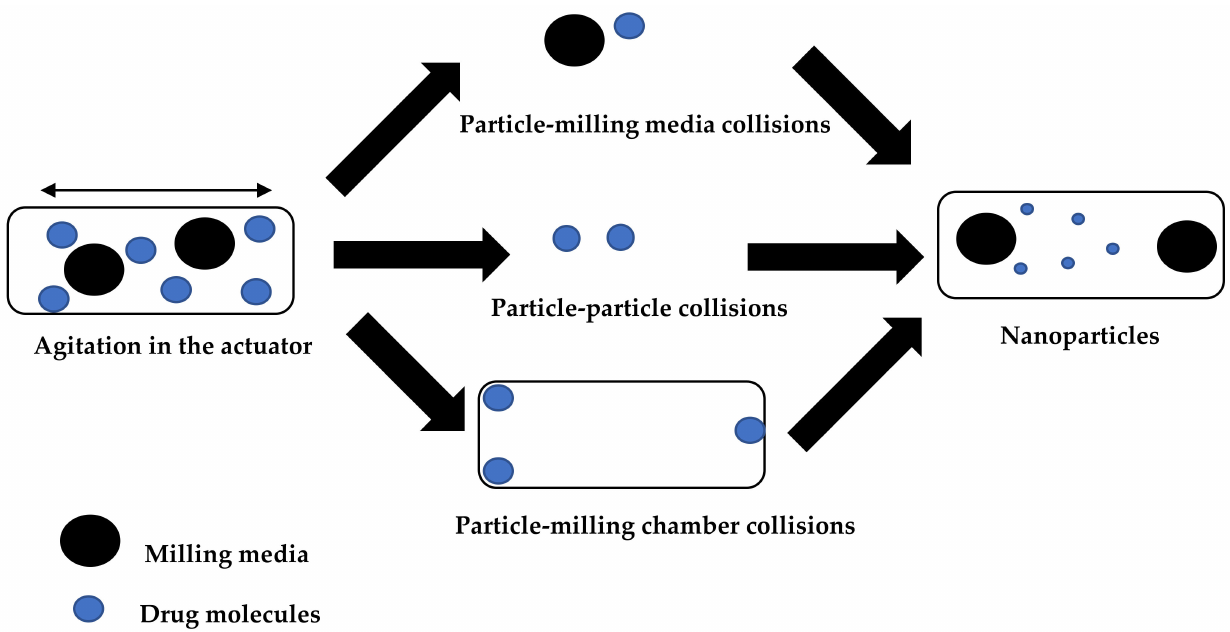
Figure 1. Schematic depiction of the wet media milling process used to produce